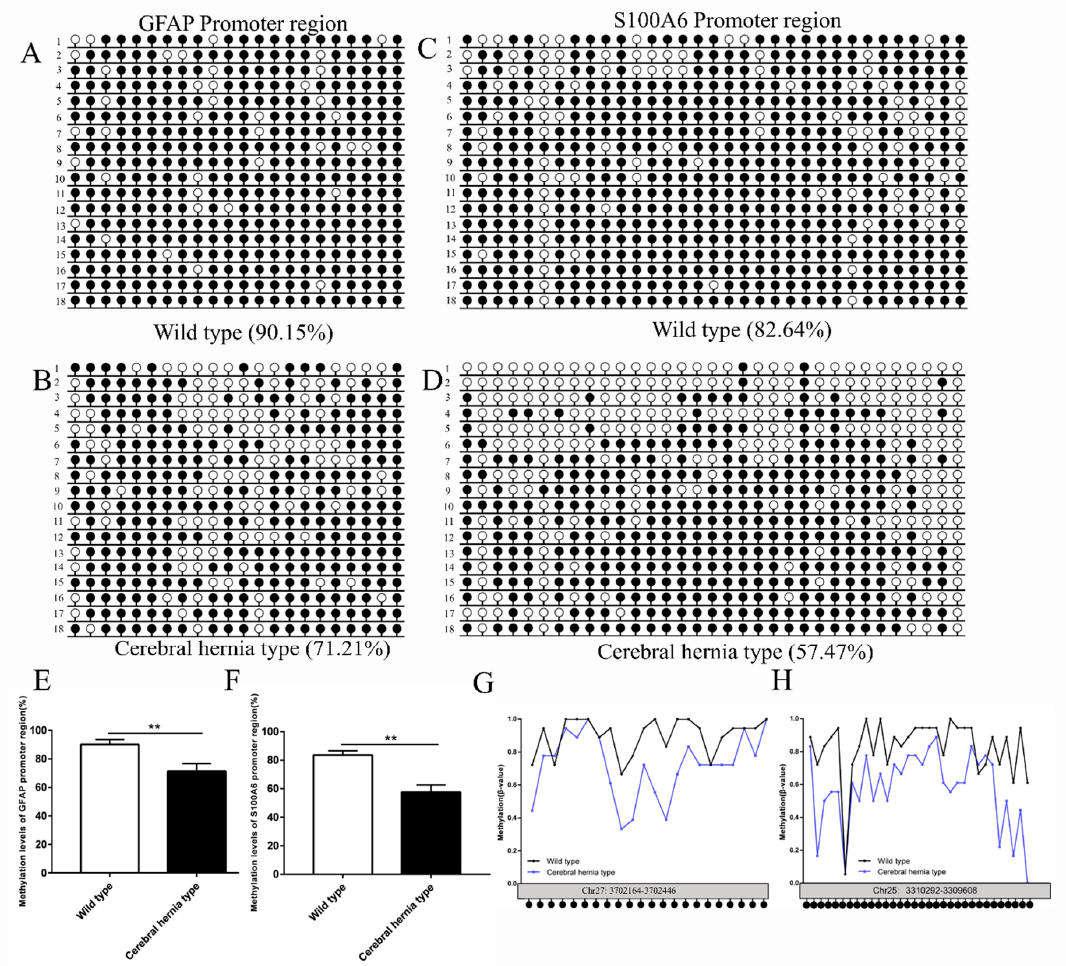
Figure 7. Methylation levels of GFAP and S100A6 in promoter regions are decreased in telencephalon of cerebral hernia type chickens compared with wild type chickens. ( A , B ) Cytosine methylation profiles of GFAP promoter sequences in telencephalon of wild type (A) and cerebral hernia type (B) chickens, respectively. The cytosine methylation profiles were detailed as wild type 1 (rows 1, 2, 3, 4, 12, and 13), wild type 2 (rows 5, 6, 7, 9, 10, and 14), wild type 3 (rows 8, 11, 15, 16, 17, and 18), Cerebral hernia type 1 (rows 2, 3, 4, 5, 7, and 13), Cerebral hernia type 2 (rows 6, 8, 10, 11, 14, and 17) and Cerebral hernia type 3 (rows 1, 9, 12, 15, 16, and 18). ( C , D ) Cytosine methylation profiles of S100A6 promoter sequences in telencephalon of wild type ( C ) and cerebral hernia type ( D ) chickens. The cytosine methylation profiles were detailed as wild type 1 (rows 1, 2, 4, 5, 12, and 14), wild type 2 (rows 3, 6, 8, 9, 13, and 17), wild type 3 (rows 7, 10, 11, 15, 16, and 18), Cerebral hernia type 1 (rows 1, 3, 7, 11, 14, and 15), Cerebral hernia type 2 (rows 2, 6, 8, 9, 13, and 16) and Cerebral hernia type 3 (rows 4, 5, 10, 12, 17, and 18). ( E , F ) Quantitative analysis results for methylation of GFAP and S100A6 promoter sequences between wild type ( E ) and cerebral hernia type ( F ) chicken telencephalon, respectively. The methylation levels are both decreased in the GFAP and S100A6 promoter sequences in telencephalon of chickens with cerebral hernia. ( G , H ) The methylation levels of GFAP ( G ) and S100A6 ( H ) promoter regions at each CpG sites are shown by polyline diagram between wild-type and cerebral hernia-type chickens. For the above results, T vector cloning is obtained from three repeated samples, and six positive clones are selected for each biological sample (18 positive clones from three independent samples for each group) to calculate the percentage of methylation. The 18 methylation maps of each group are shown in A, B, C, and